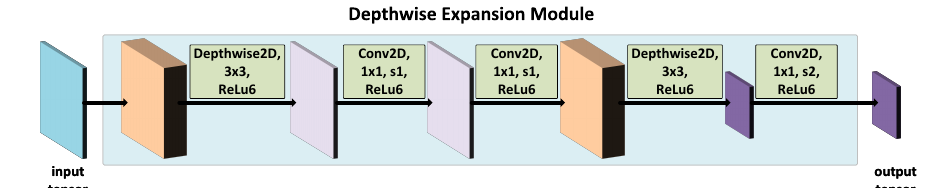
Figure 16. Depthwise expansion